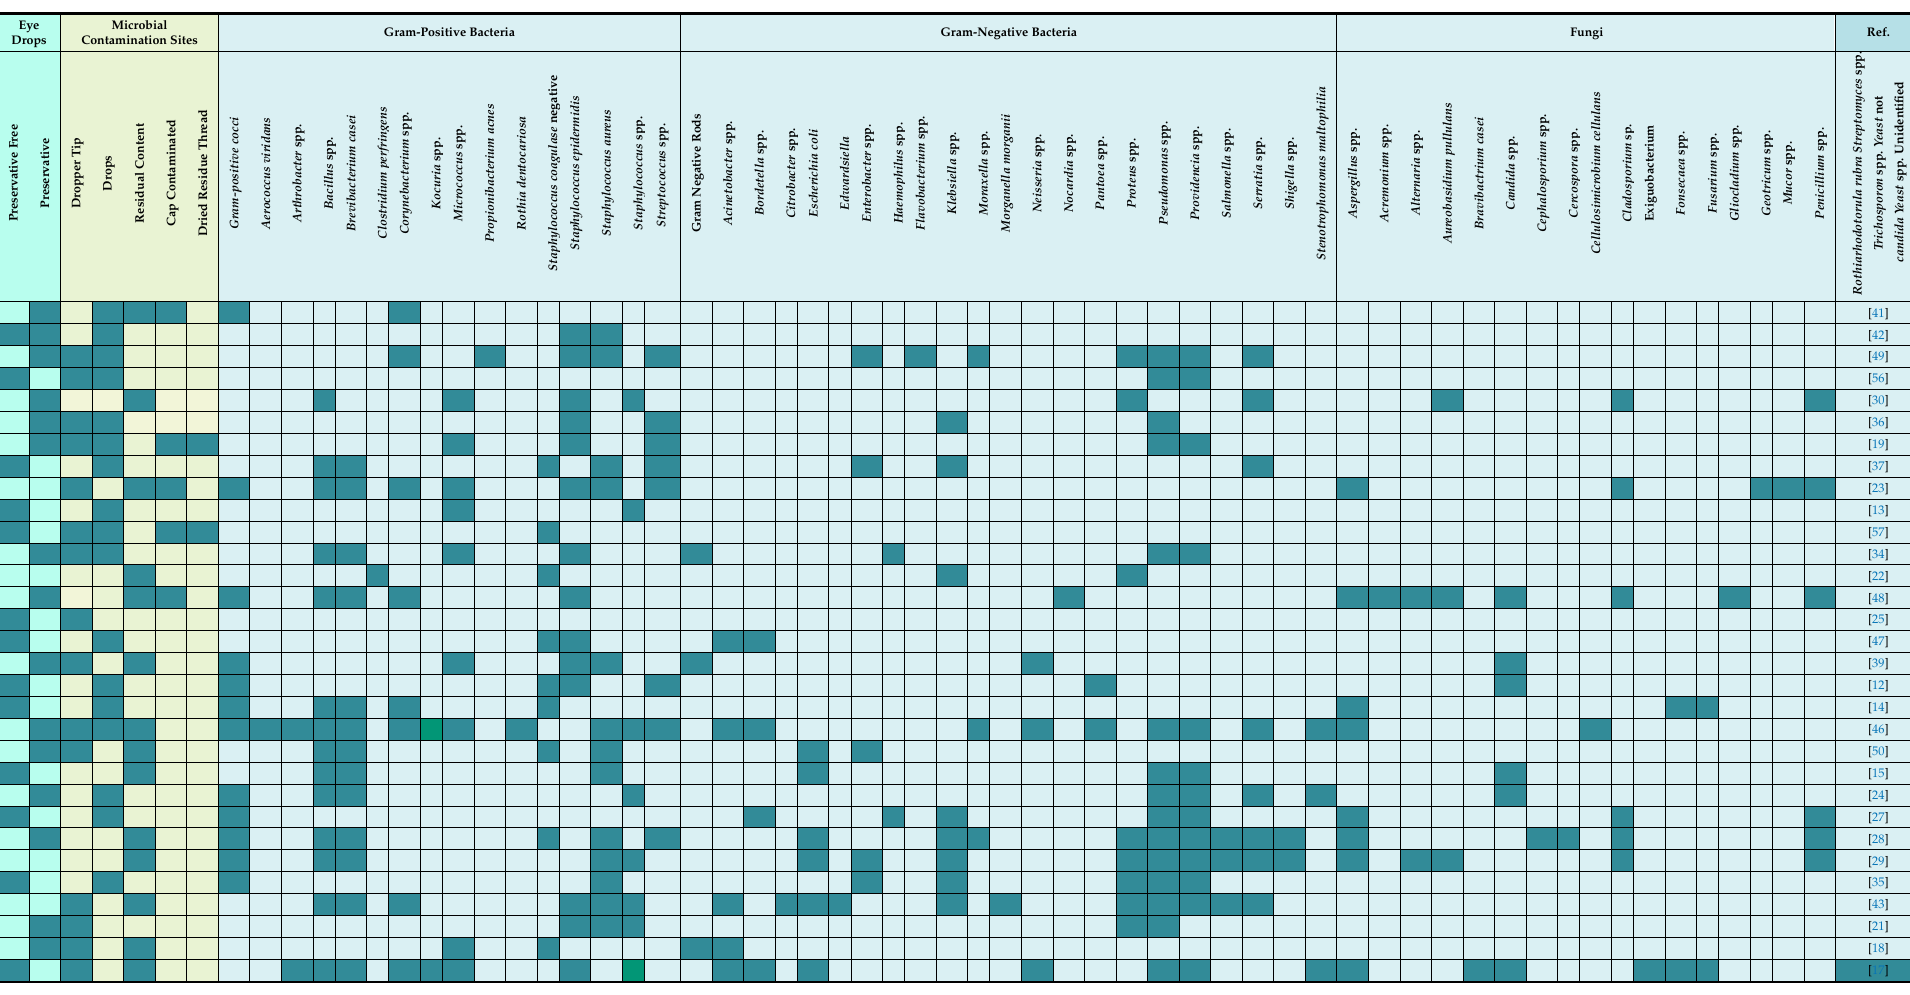
Table 4. Isolated microorganisms from tested eye